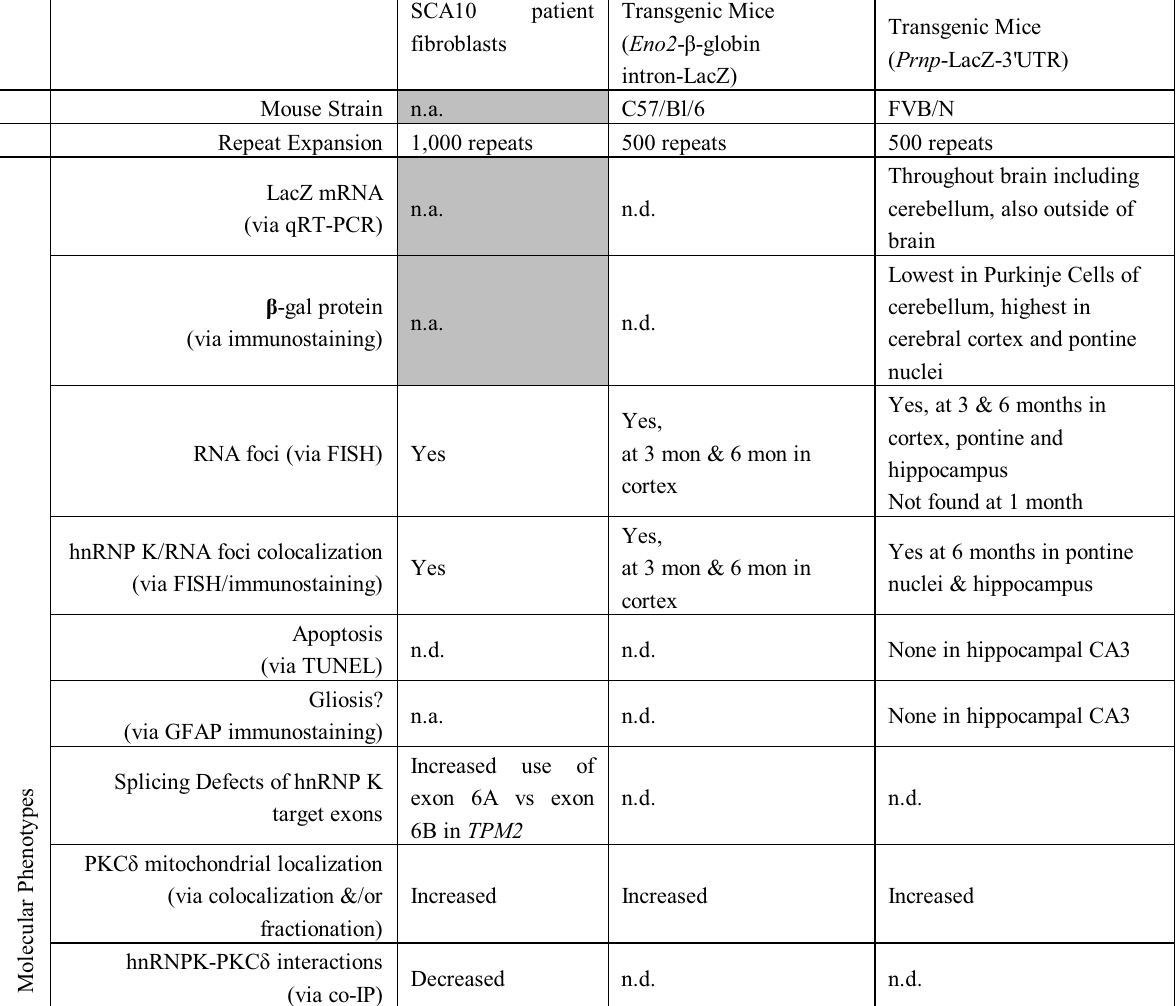
Table 1. Comparison of Molecular Analyses of SCA10 transgenic mouse